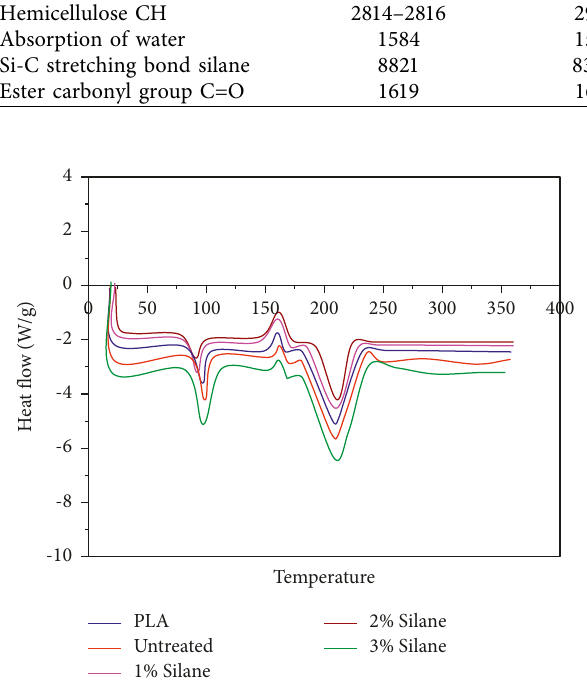
Figure 5: Differential scanning calorimetry (DSC).